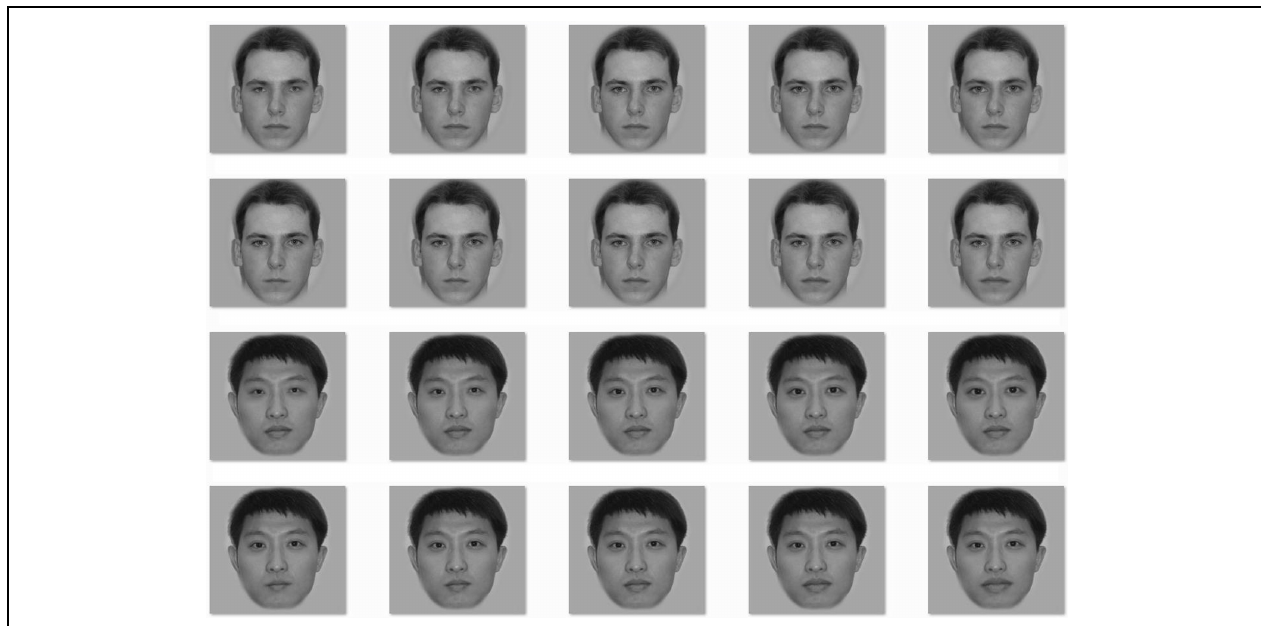
FIGURE 3 | Examples of size change of the two eyes (Rows 1 and 3) or the mouth (Rows 2 and 4) in a Caucasian face (Rows 1 and 2) and an Asian face (Rows 3 and 4). The middle face of each row is the original face upon which the manipulations were made. The leftmost face has eyes or mouth